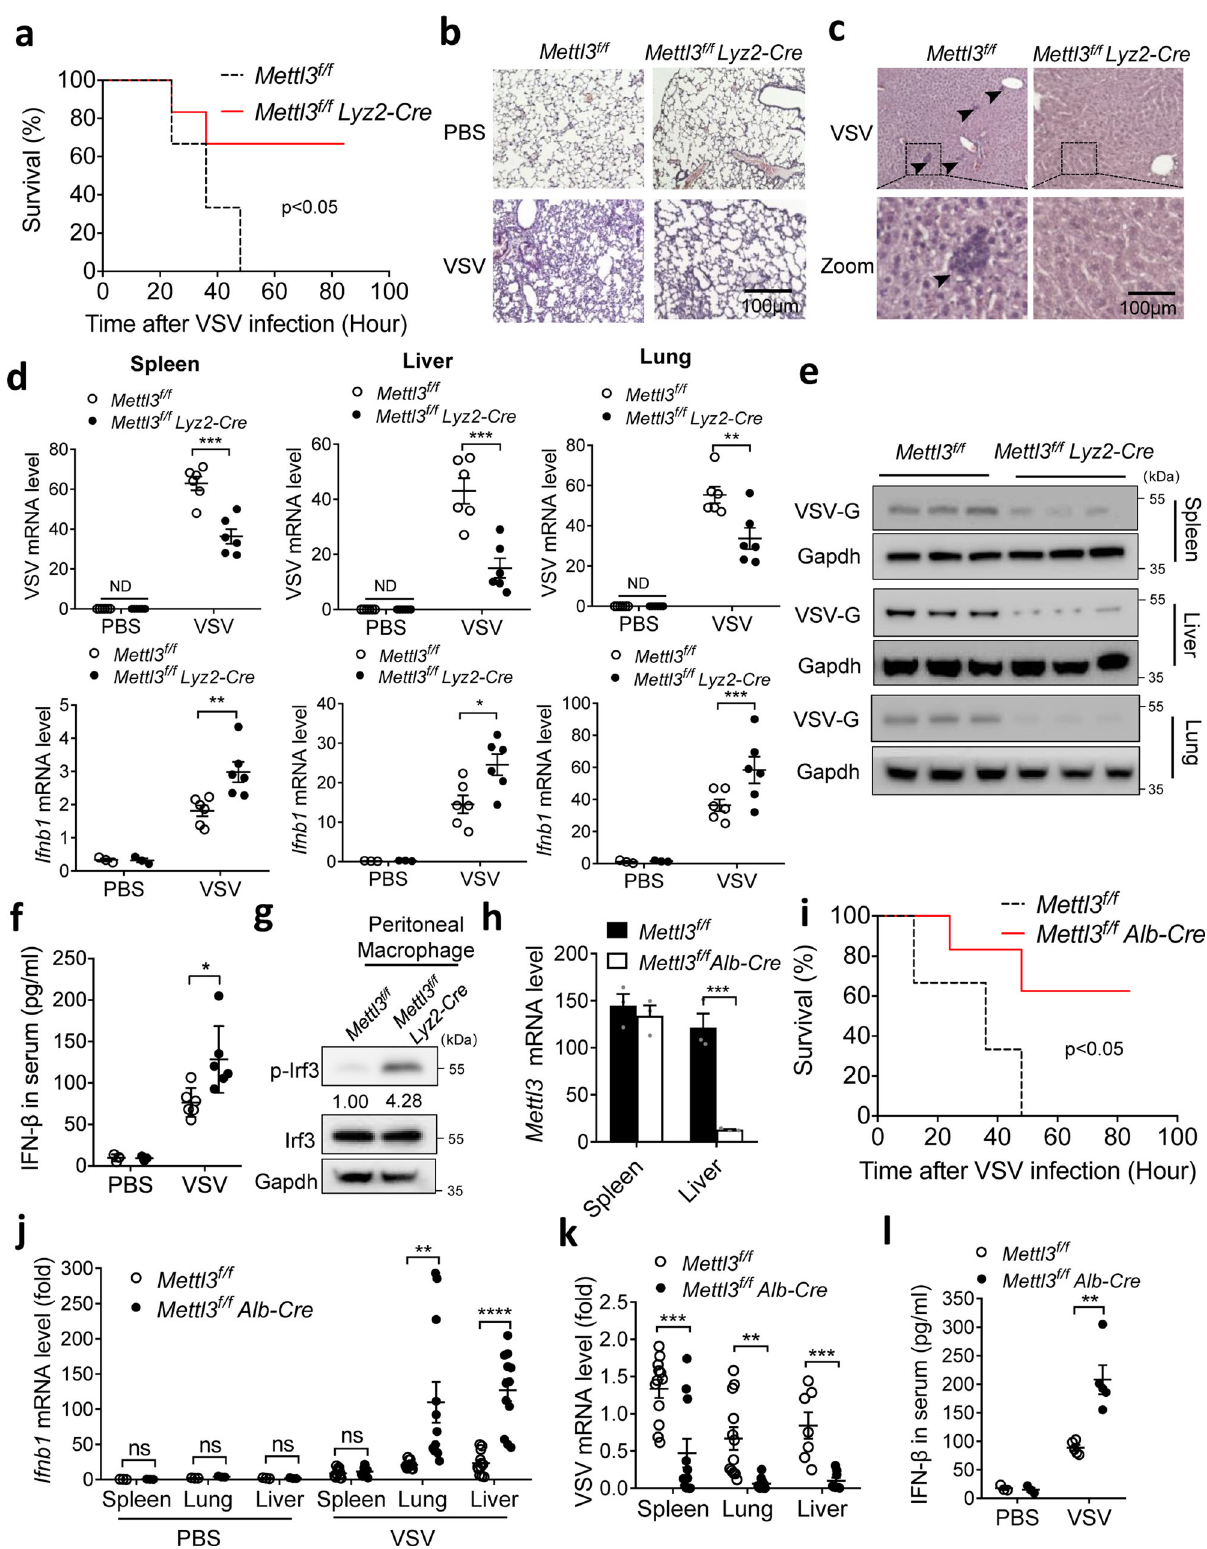
(PAR-CLIP) sequencing and miCLIP-seq. Consistent with a recent report 20 , METTL3 and m 6 A showed speci fi c binding regions on Ifnb1 transcript (Supplementary Fig. 5b – e). Moreover, as VSV RNAs include the positive-sense ( + ) RNAs and negative-sense ( − ) genomic RNA, through strand-speci fi c sequencing and analyzing, we found that only VSV ( + ) RNAs showed abundant METTL3